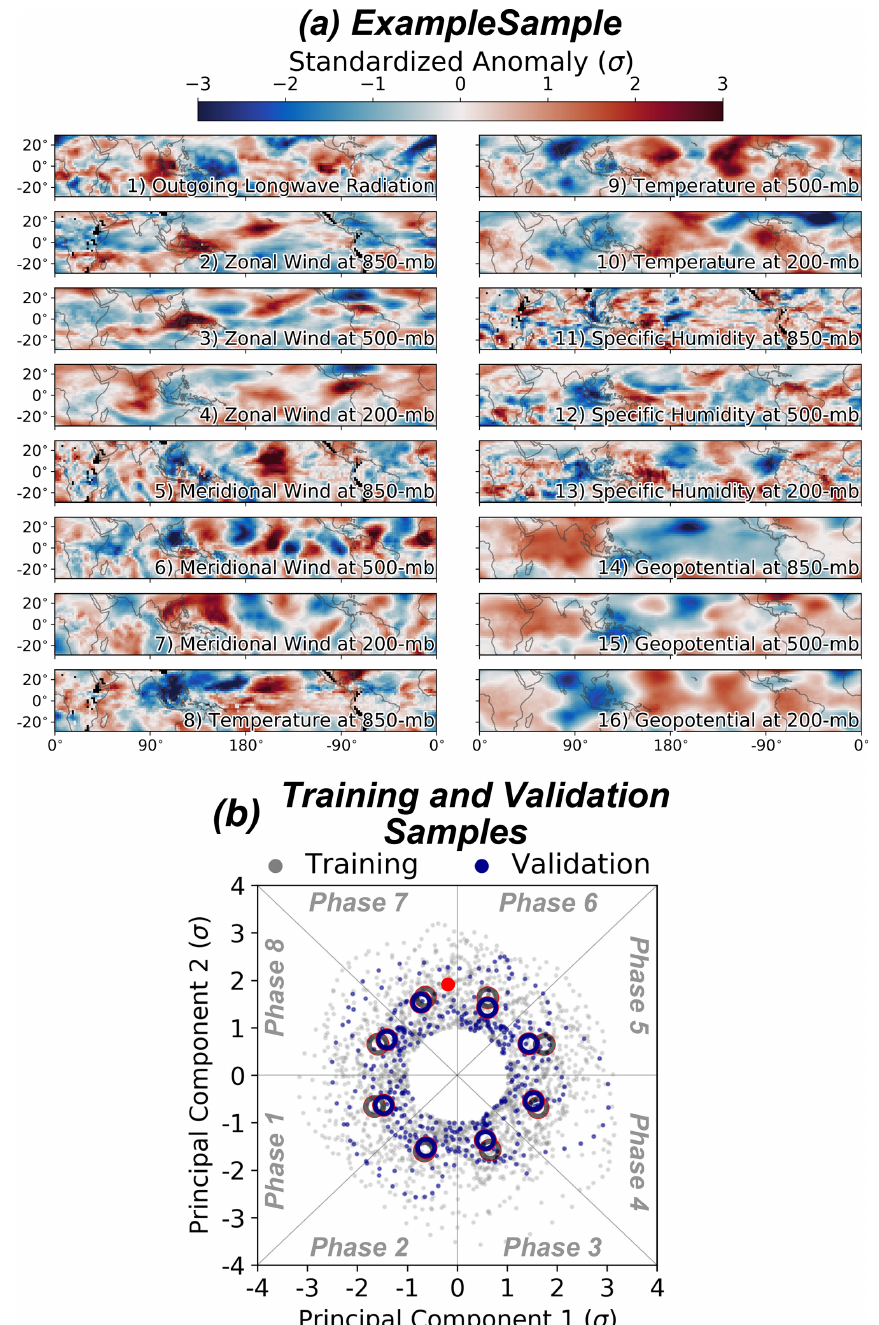
Figure 2. (a) An example input sample, which corresponds to a phase-7 MJO day. Each variable was standardized for each grid point to have zero mean and unit variance across all samples from 1 January 1980 through 31 December 2016. (b) A visualization of how the samples are split between the training and validation datasets. The red dot corresponds to the sample shown in (a) , the gray dots denote the training samples, and the purple dots denote the validation samples. The gray rings denote the training sample mean phase and amplitude for each phase, and the blue rings denote the same but for the validation